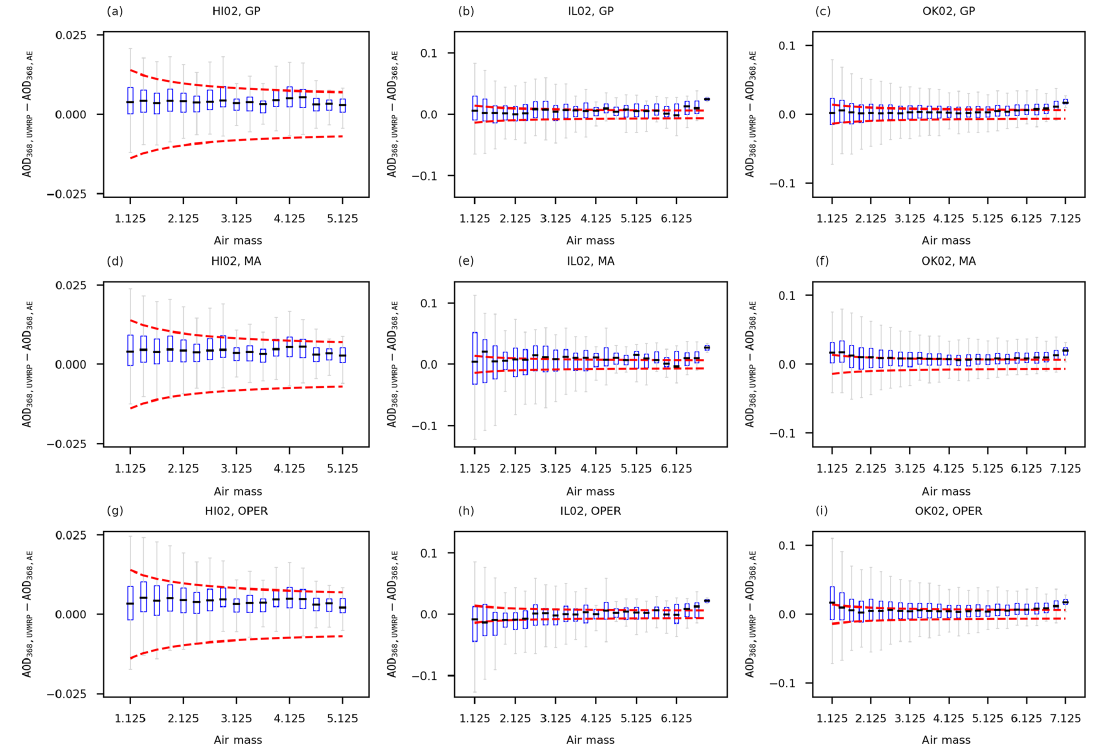
Figure C1. Box-and-whisker plots of AOD 368 , UVMRP − AOD 368 , AE as a function of air mass by the three methods (i.e., from top to bottom: GP, MA, OPER) at the three test sites (i.e., from left to right: HI02, IL02, OK02). Panels (a) , (b) , and (c) display the box-and-whisker plots for the GP method at HI02, IL02, and OK02, respectively. Similarly, panels (d) , (e) , and (f) are for the MA method and panels (g) , (h) , and (i) are for the OPER method. Each blue bin covers a 0.25 air mass range. The dashed red lines show the WMO AOD U95 upper and lower